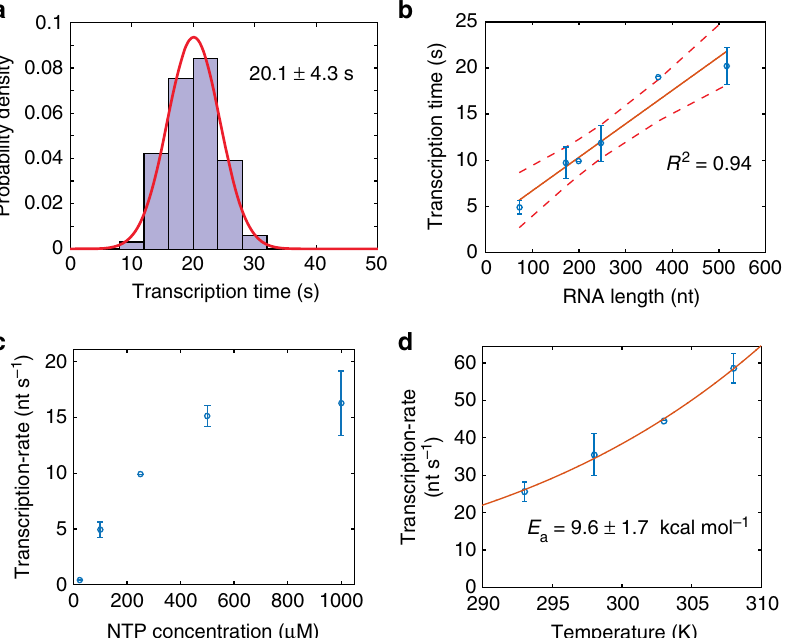
Fig. 3 Transcription progression. a The time to transcribe an RNA of a speci fi c length, here the 517 nt RNA construct, is broadly distributed. The mean and standard deviation of the Gaussian distribution are shown. Number of molecules analyzed ( n ) = 83. b The average time to transcribe an RNA is proportional to its length. 95 % prediction intervals of the fi t are shown. c Effect of NTP concentration on transcription rate for the 171 nt RNA construct. d Effect of temperature on transcription rate shown for the 517 nt RNA construct. The data were fi tted to the Arrhenius equation. For all the plots, error bars represent the standard deviation obtained from biological replicates. Source data are provided as a Source Data fi